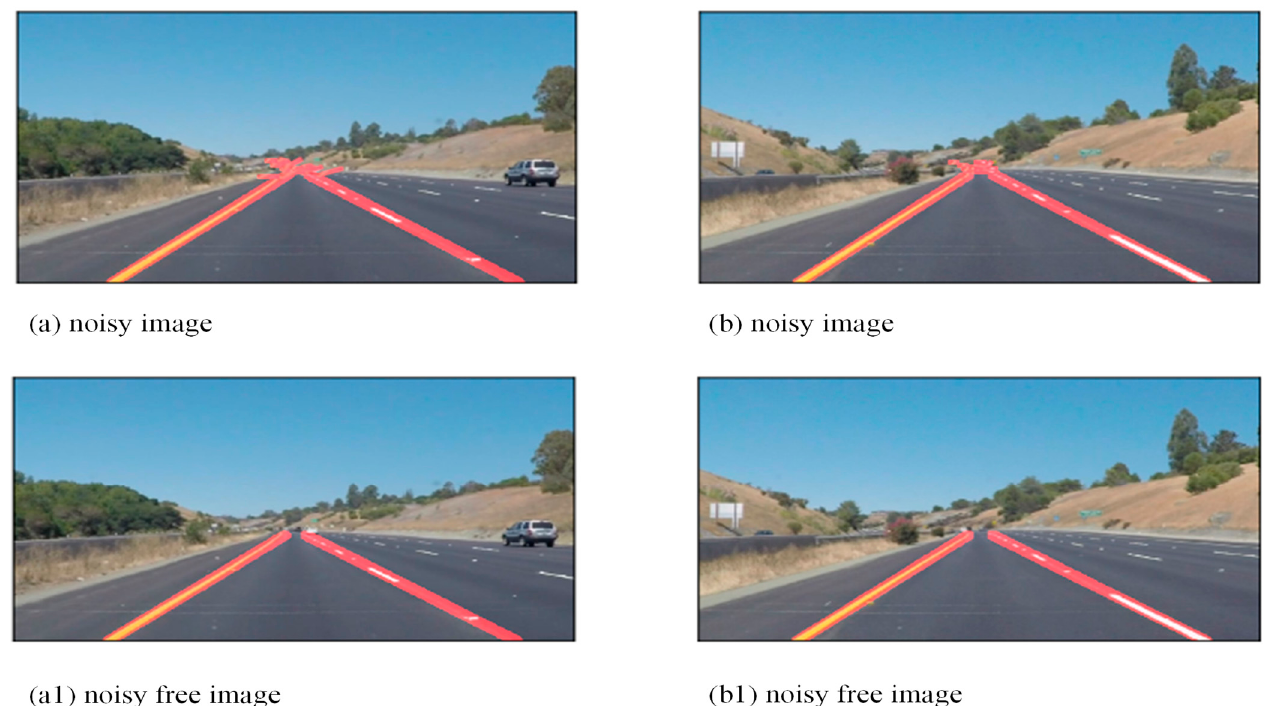
Figure 5. Multiple overlapping lines ( a , b ), and the results of the non-max suppression ( a1 , b1